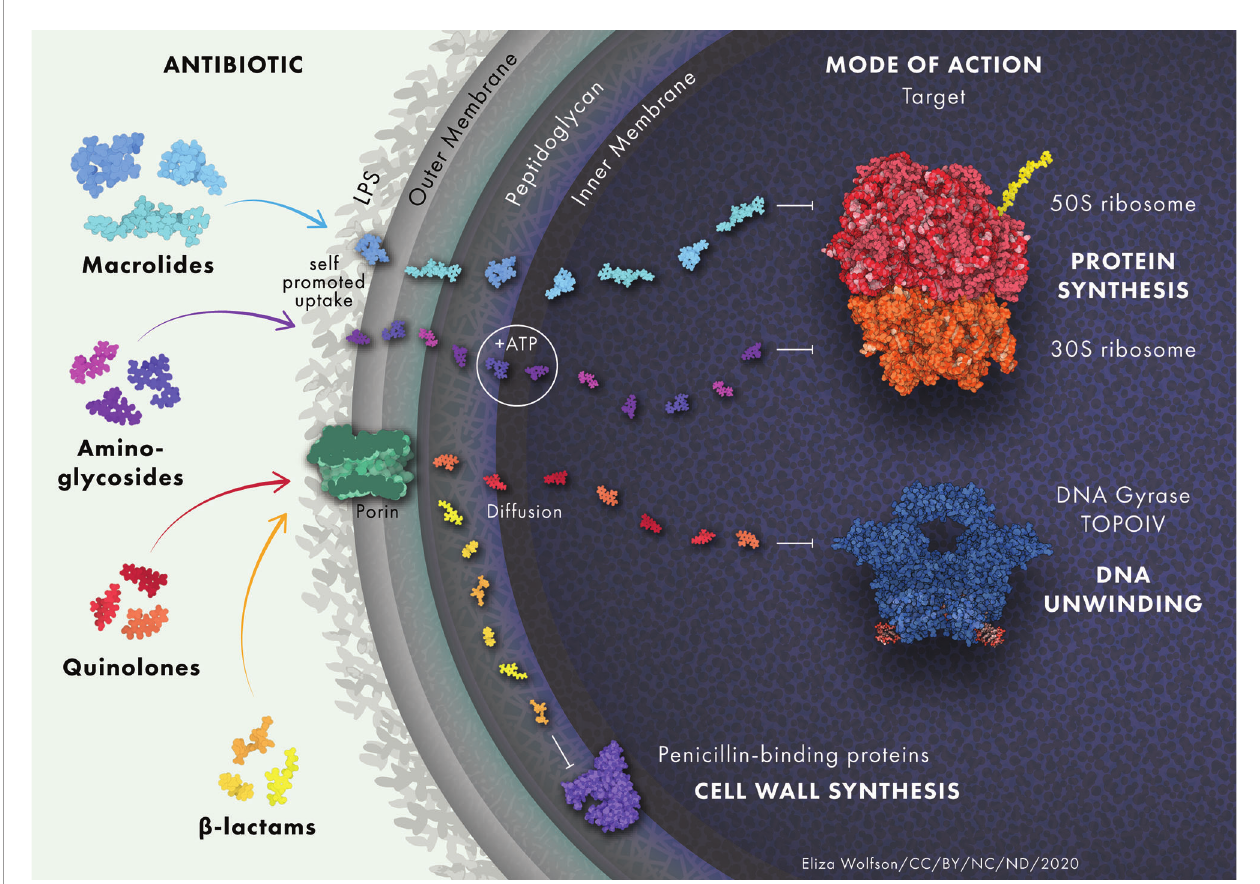
FIGURE 1 | Antibiotic uptake in P. aeruginosa . Aminoglycosides diffuse through the outer membrane due to electrostatic interactions between the positively charged aminoglycoside and the negatively charged LPS. They undergo rapid energy-dependent accumulation into the cell with the use of electron transport and ATP hydrolysis. Once inside the cell, aminoglycosides bind to the 30S subunit of ribosomes to inhibit protein synthesis. b -lactam antibiotics target trans-peptidases on the cytoplasmic membrane that play a vital role in the assembly and cross-linking of cell wall peptidoglycan. Macrolides diffuse across the lipid bilayer due to their hydrophobic nature. They bind to the 50S ribosomal subunit and cause the dissociation of peptidyl-tRNA from the ribosome inside the cell. Quinolones inhibit DNA gyrase and DNA topoisomerase IV in Gram-negative and Gram-positive bacteria, respectively, leading to double stranded DNA breaks. Protein and drug structures were generated with Protein Imager (Tomasello et al.,